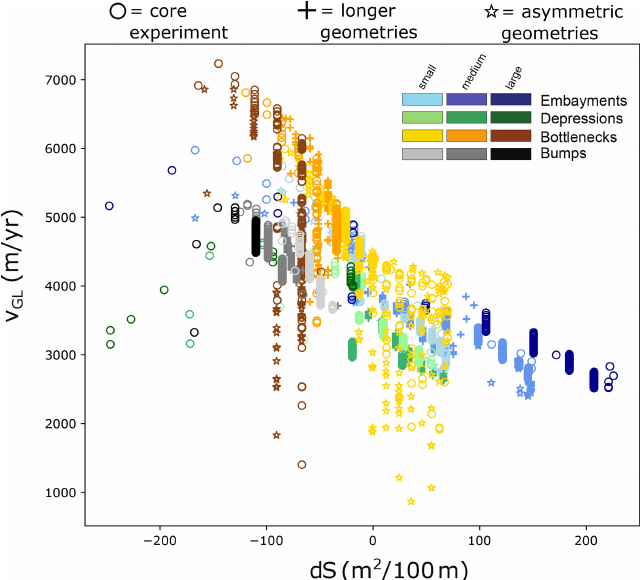
Figure A4. Correlation of v GL over d S for all geometries including asymmetric and longer ones. Differences between this relationship and the relationship Q GL /S over d S originate from time instances when the ice front is grounded well above flotation (and therefore v GL not ∝ Q GL /S ) and because we measure v GL only along the central flow line of the